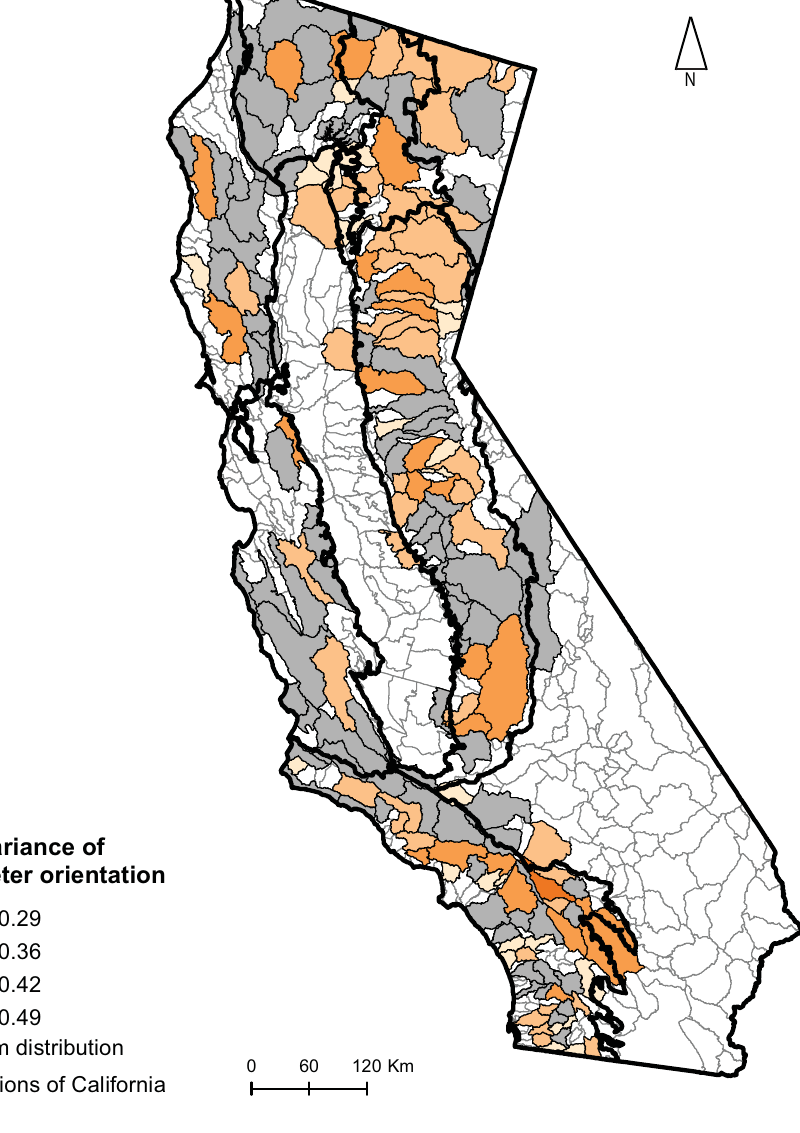
Figure 6. Circular variance for the mean fire orientation in watersheds where fires display preferential alignment (Figure